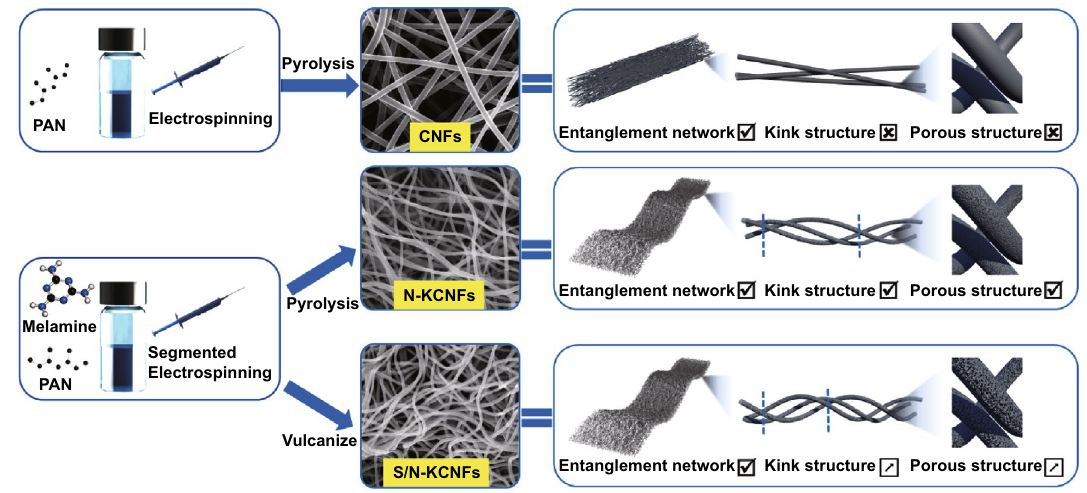
Fig. 3 Schematic diagram of preparation of CNFs, N-KCNFs, and S/N-KCNFs. And judging from three levels of influencing factors of flexibil- ity, in which ’tick’ means available, ’cross’ means not available, and ↗ means